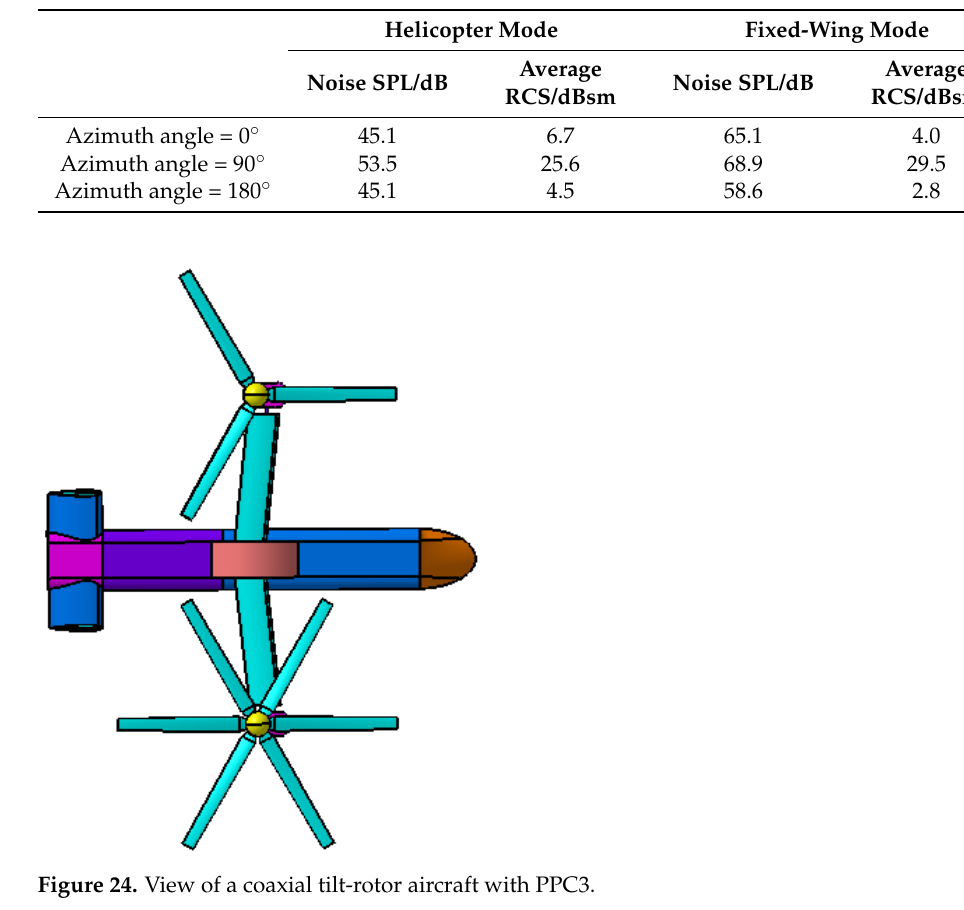
Figure 23. View of a coaxial tilt-rotor aircraft with PPC2. Table 21. Noise SPL and average RCS values with PPC2.